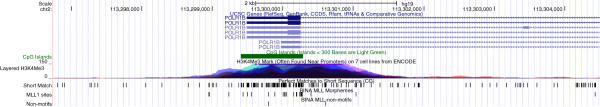
Human genomic DNA with one CG encompassing POLR1B gene. Horizontal green bar marks the CGI position. Track labeled “Short Match” marks the position of CpGs. Track-labeled “MLL1 sites” marks morpheme positions; “non-motifs” mark the position of sequences not found in results of SELEX assays [24]. Track labeled “Layered H3K4me3” shows the position of H3K4me3 marks, determined by the ENCODE project using a variety of cell lines including: lymphoblastoid cells (GM12878), H1 human embryonic stem cell line (H1-hESC), human skeletal muscle myoblasts (HSMM), human umbilical vein endothelial cells (HUVEC), erythroleukemia type cell line (K562), normal human epidermal keratinocytes (NHEK), and normal human lung fibroblasts (NHLF) [59]. A layered representation is displayed in order to provide an overview of H3K4me3 profiles [59].